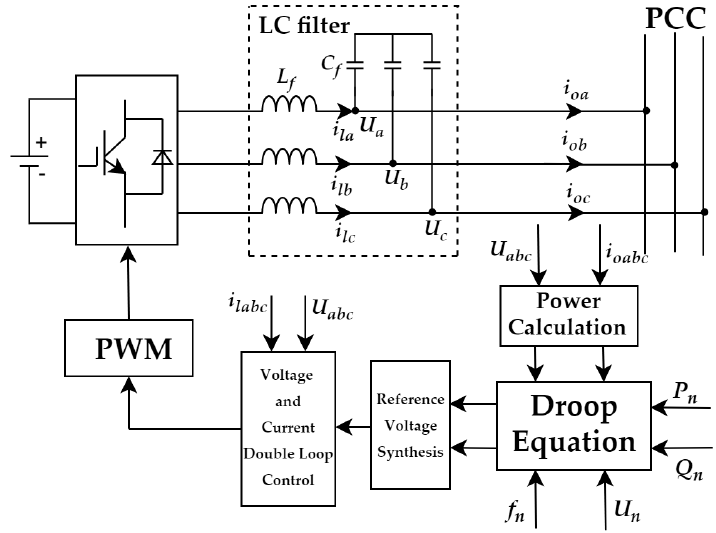
Figure 6. A structure diagram of the voltage source inverter control system. PWM: Pulse Width Modulation; PCC: Point of Common Coupling; LC: